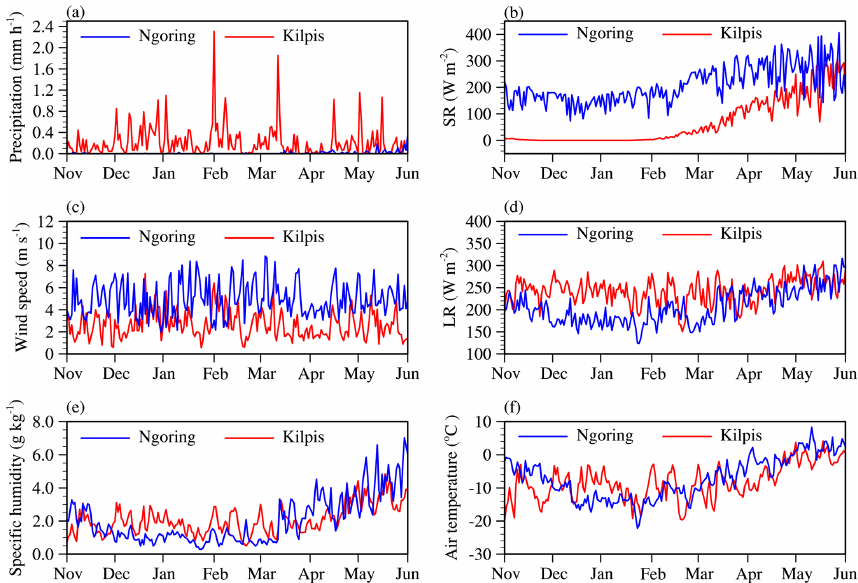
Figure 3. Comparison of daily average values of the meteorological variables for Tibet from 2015 to 2016 and for Kilpisjärvi from 1992 to 1993. (a) Precipitation, (b) downward SR, (c) wind speed, (d) downward LR, (e) specific humidity, and (f) air temperature. “Ngoring” represents the Tibet region, and “Kilpis” represents Kilpisjärvi region. Table 1. Ranges and averages of the meteorological variables of Tibet (2015–2016) compared with Kilpisjärvi (1992–1993) during the ice-covered period (12 December–18